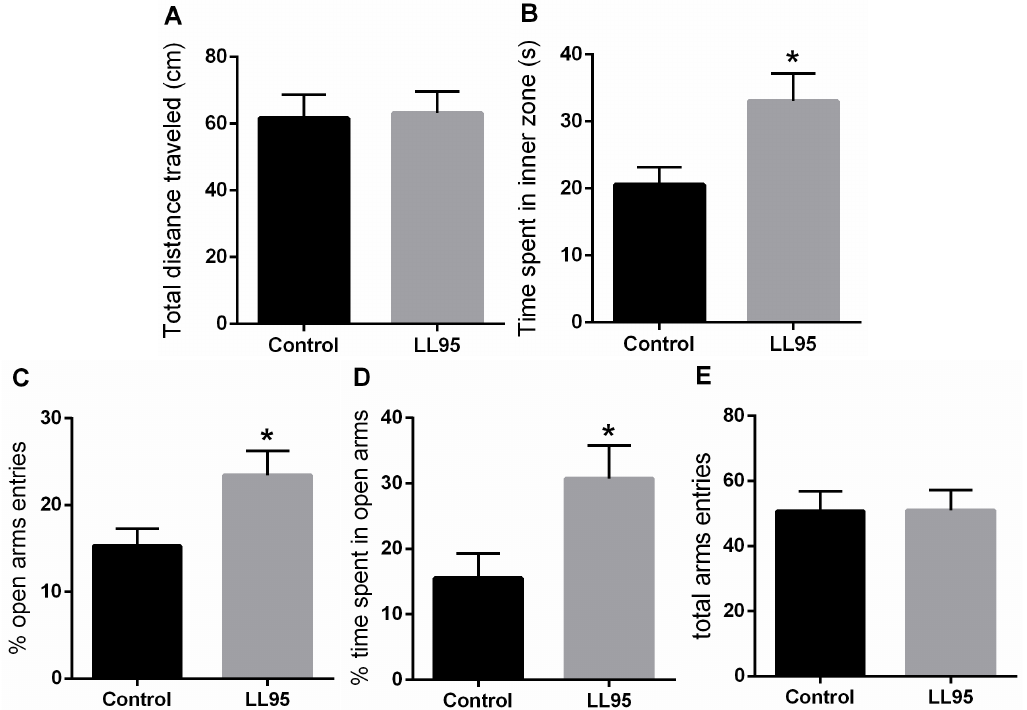
Figure 2. E ff ect of L. lactis LL95 on locomotor activity and anxiety-like behaviour in the OFT and EPM. There was no di ff erence in the distance travelled ( A ) between groups in the OFT. L. lactis LL95 induced an increase on the time spent in inner zone than control group ( B ). L. lactis LL95 induced an increased in per cent of open arms entries and per cent time spent in the open arms ( C , D ). The total number of entries did not di ff er between groups ( E ). Data are expressed as mean ± S.E.M. ( n = 6). * p < 0.05 vs. control group.